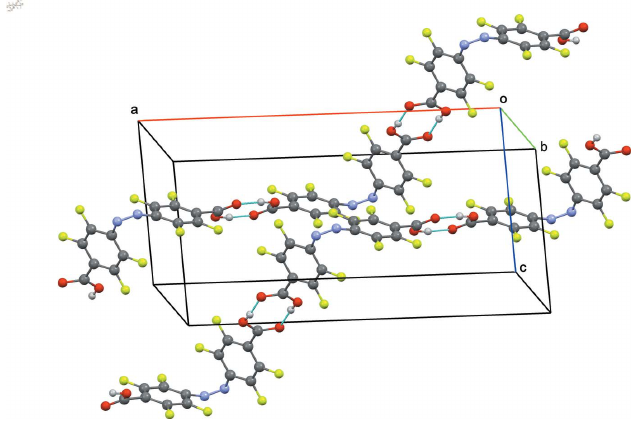
Figure 4 Partial view of the packing showing two hydrogen-bonded chains in (II). Hydrogen bonds are shown as dotted lines and hanging hydrogen bonds were omitted for clarity.